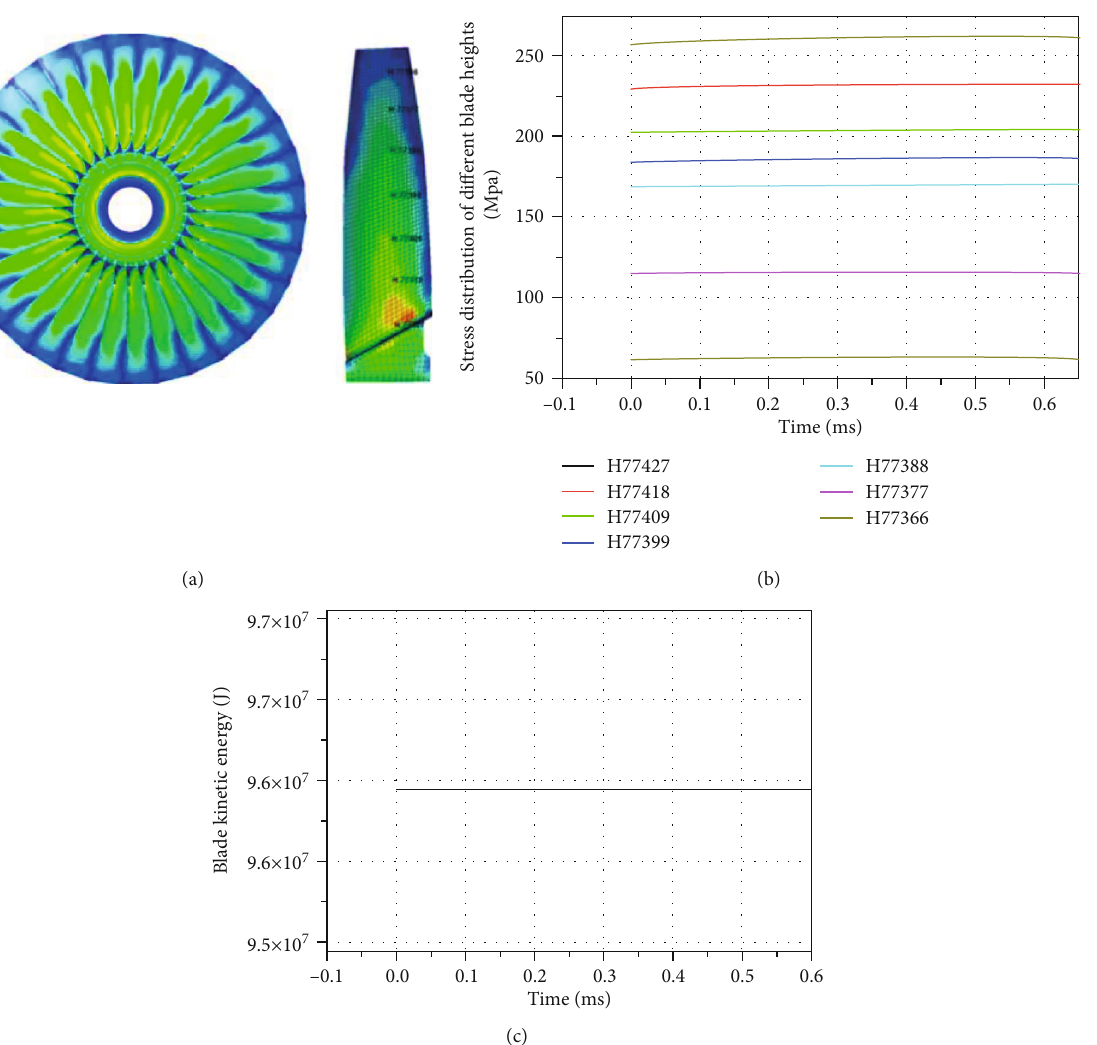
Figure 7: The state diagram of each component under steady-state operation: (a) stress distribution of blade, (b) stress of di ff erent blade heights, and (c) blade kinetic energy versus time.